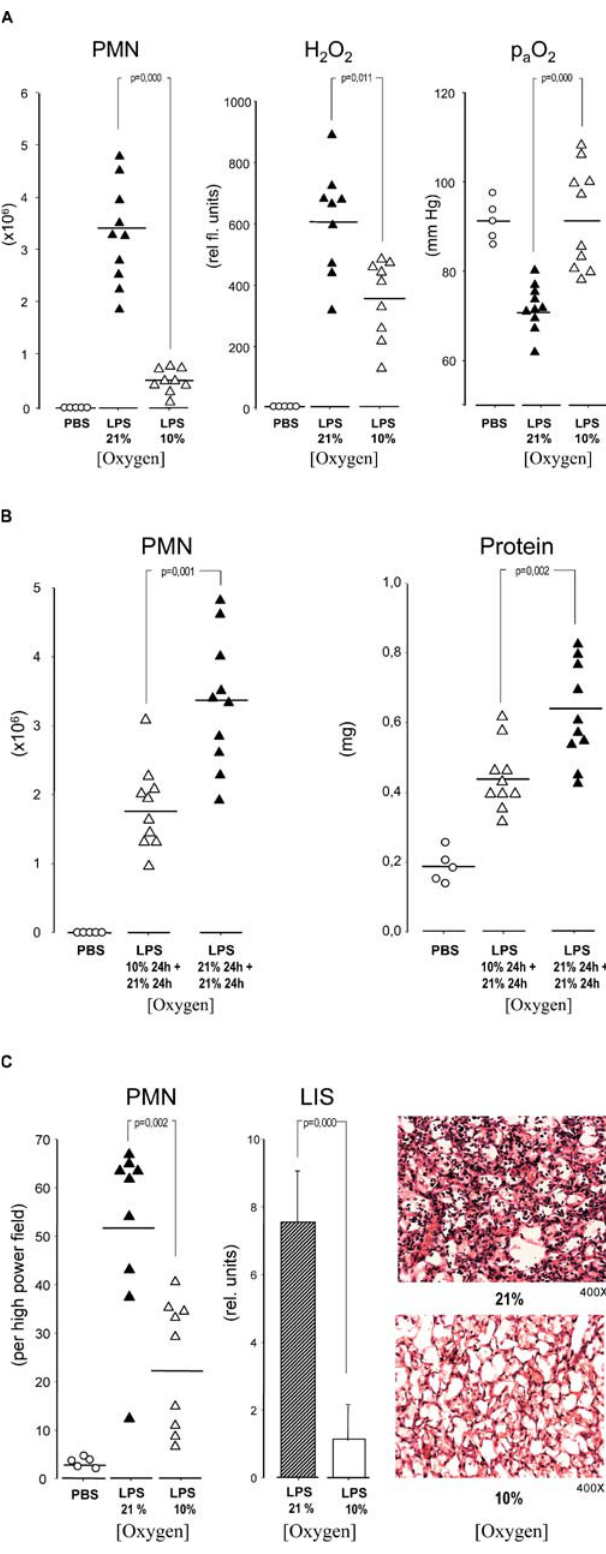
Figure 6. Hypoxia Down-Regulates Neutrophils and Protects Lung Tissue from Inflammatory Damage (A) Exposure of IT LPS-injected mice to hypoxic (10%) oxygen levels for 48 h atmosphere leads to a significantly decreased accumulation of PMNs (left graph), production of LPS-triggered oxygen reactive metabolites in lungs (center graph), and improved lung gas